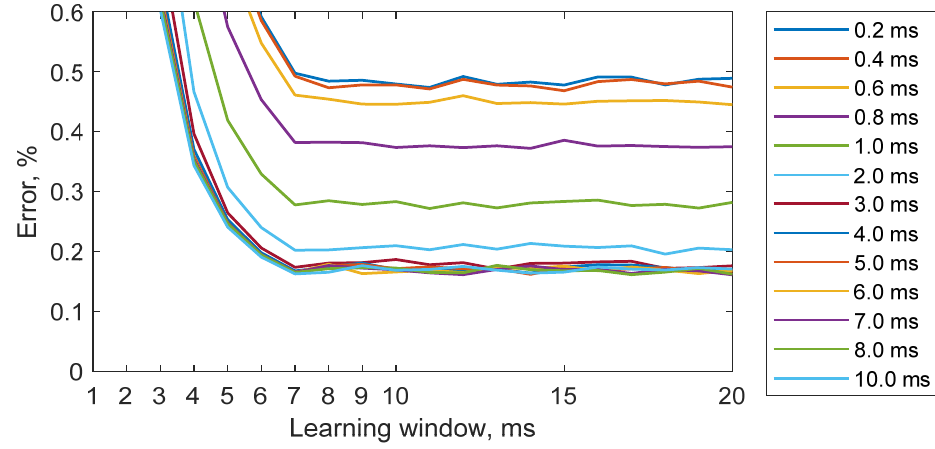
Figure 9. Influence of the algorithm parameters on the error of disturbance inception detection.